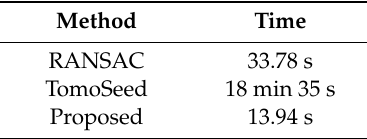
Table 4. Time cost. Processing times are obtained by a regular desktop PC (Core i5-7200U). The time does not include the time expended on data splitting and splicing in RANSAC and TomoSeed.